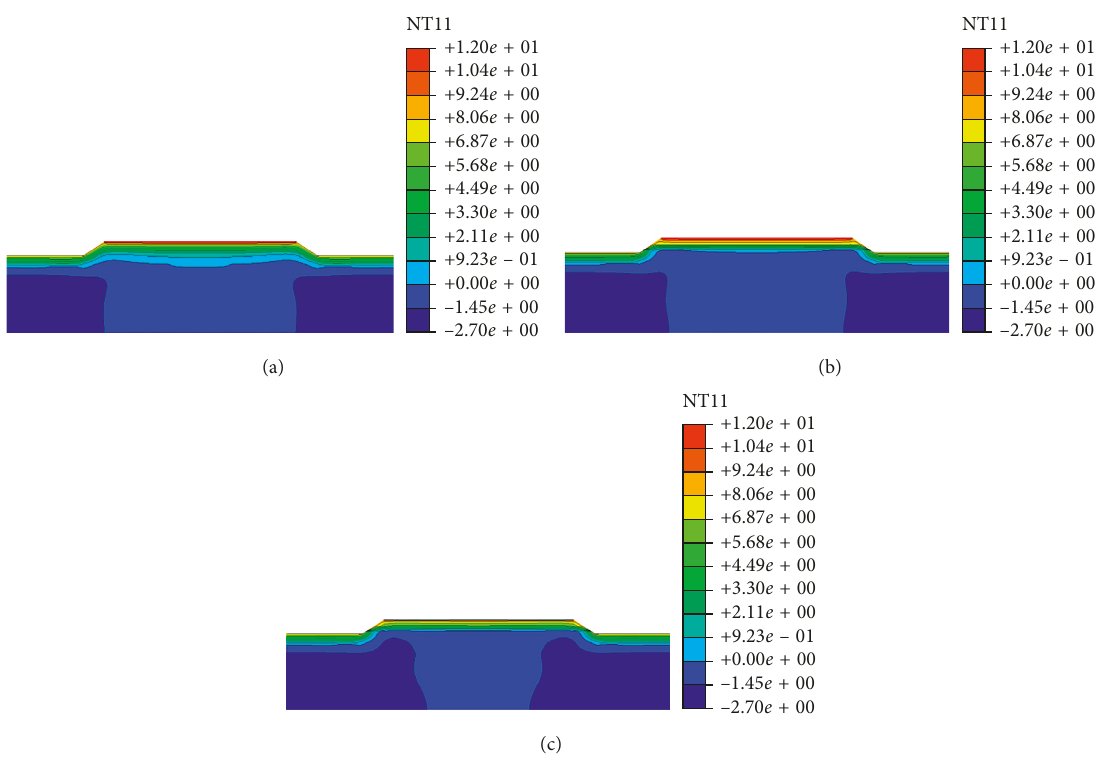
Figure 9: The tenth-year temperature fields in August for different embankments: (a) normal embankment, (b) CS embankment, (c) and RRVCS embankment.